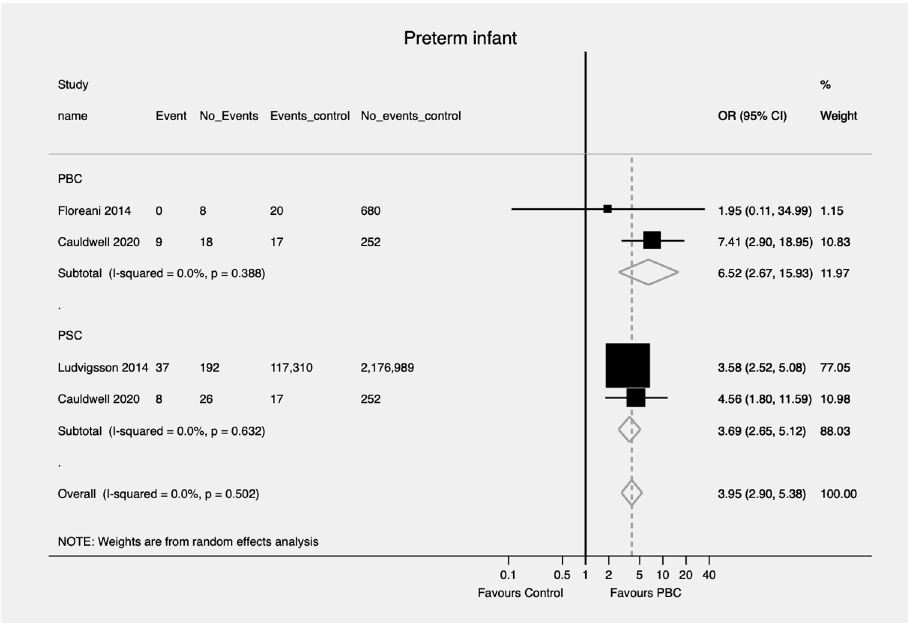
Figure 2. Preterm birth (the event) in patients with PBC and PSC compared to controls. PBC—Primary biliary cholangitis; PSC—Primary sclerosing cholangitis; OR—Odds ratio; CI—Confidence interval.